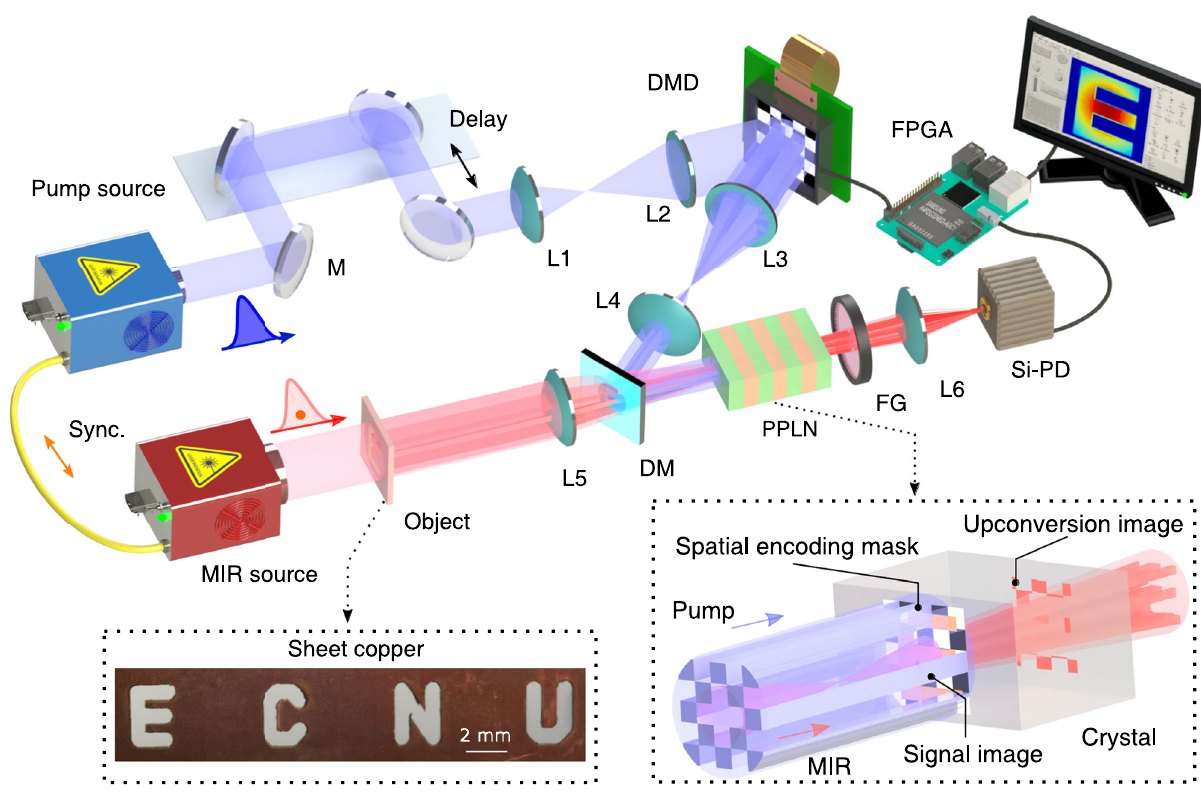
Fig. 1 | MIR single-pixel imaging based on nonlinear structured detection. A collimated MIR pulse at 3070 nm is launched at a transmission mask made of a piece of sheet copper carved with four letters. The resulting object image is pro- jected by a lens into the center of a periodically poled lithium niobate (PPLN) crystal. Simultaneously, the nonlinear crystal is pumped by a synchronous struc- tured fi eld at 1030 nm. The pump beam is spatially patterned by a digital micro- mirror device (DMD), and then combined by a dichroic mirror (DM) with the MIR lighttoperformthesum-frequencygeneration.Throughthenonlinearinteraction, a sequence of well-de fi ned pump patterns are optically imparted into the MIR